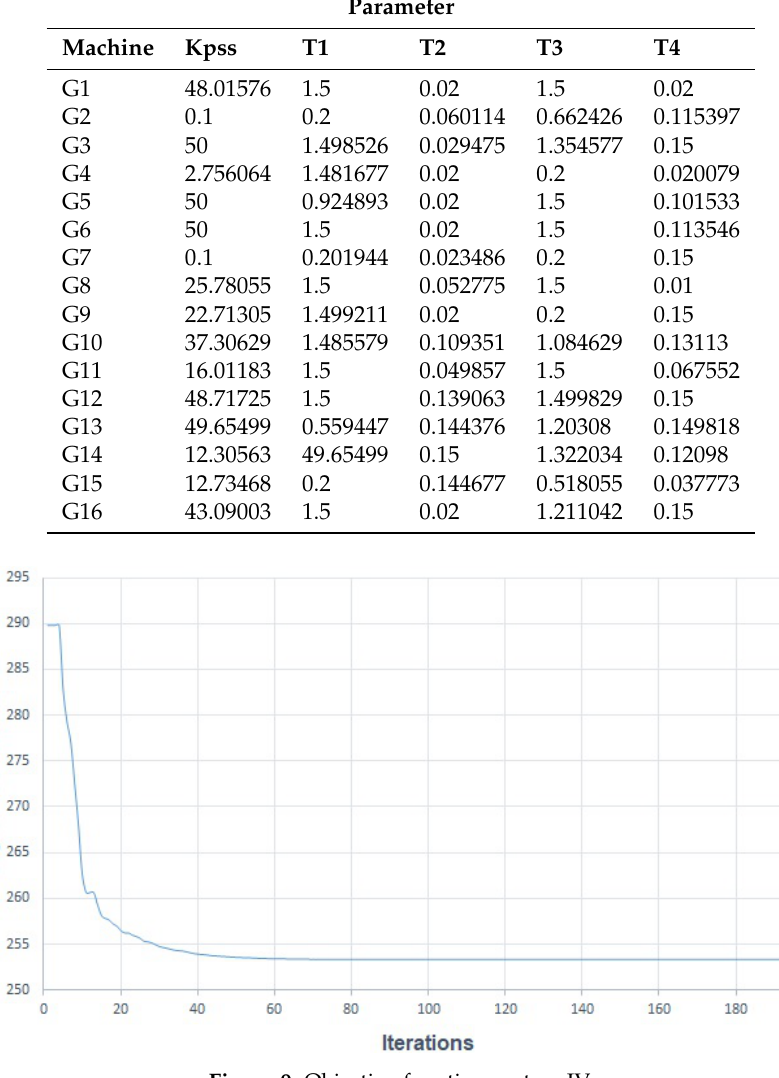
Figure 9. Objective function system